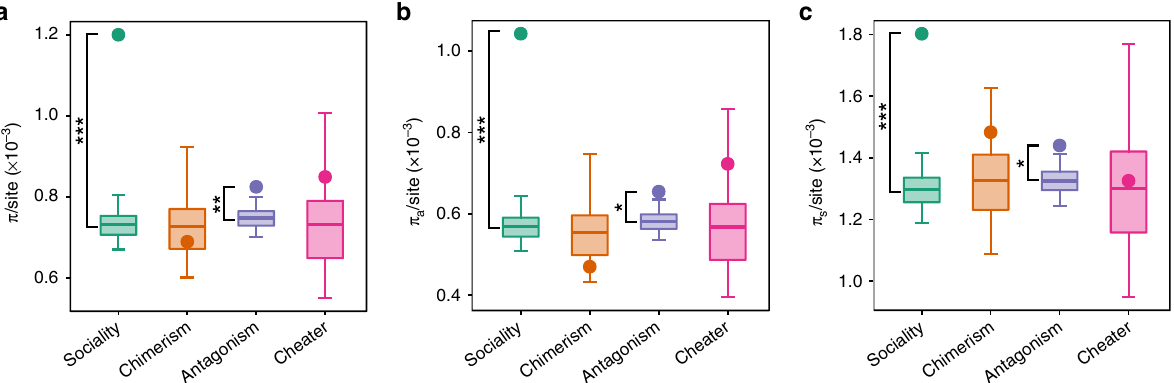
Fig. 1 Polymorphism in social genes. Average estimates of nucleotide diversity per site ( π /site) for CDS a , nonsynonymous b , and synonymous c sites for each group of genes (points) were compared with randomization distributions (boxplots). The middle line, bottom, and top of the box show the expected mean, 25th and 75th percentiles, respectively; whiskers present the 95% con fi dence interval of the distributions. Randomization distributions were generated for each group of social genes by generating a set of 10,000 random groups of genes of size N (where N corresponds to the number of genes in the particular group of social genes being tested). Randomization was done separately for each group of social genes by sampling from a set that contains that group of social genes and its corresponding background set of genes. Two-tailed p values are de fi ned as the probability of obtaining a mean as extreme as the observed only owing to chance. Signi fi cance after FDR correction: p < 0.05 *; p < 0.01 **; p < 0.001 ***. Source data are provided as a Source Data fi